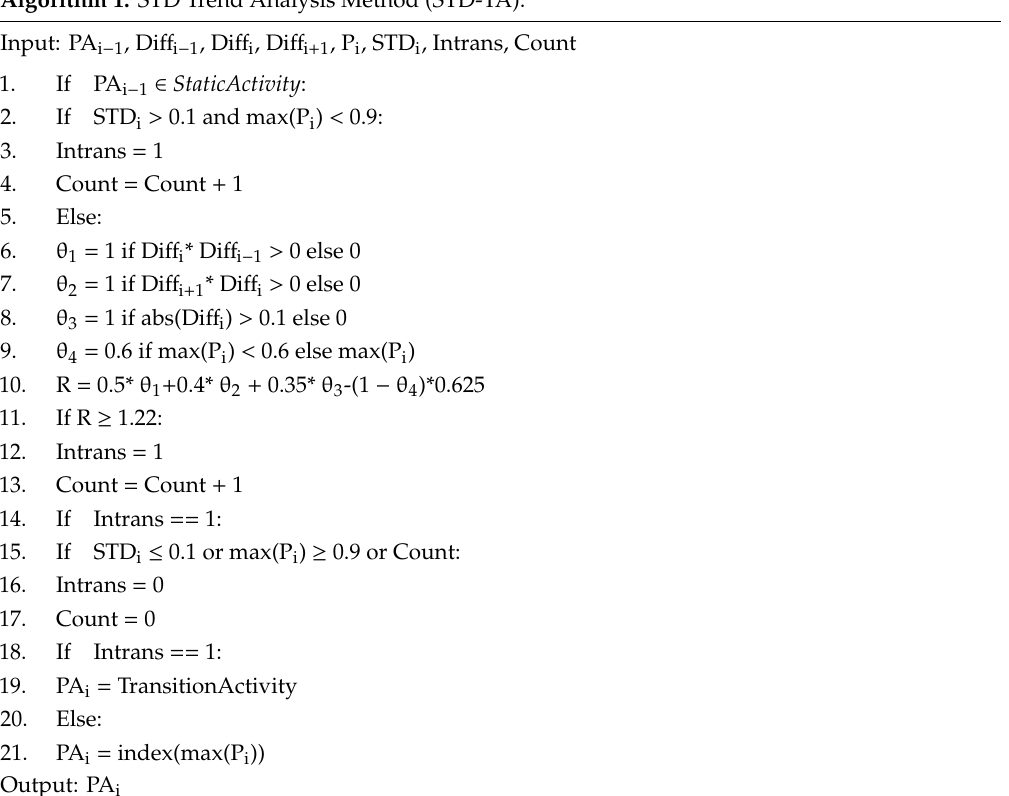
Algorithm 1. STD Trend Analysis Method (STD-TA).